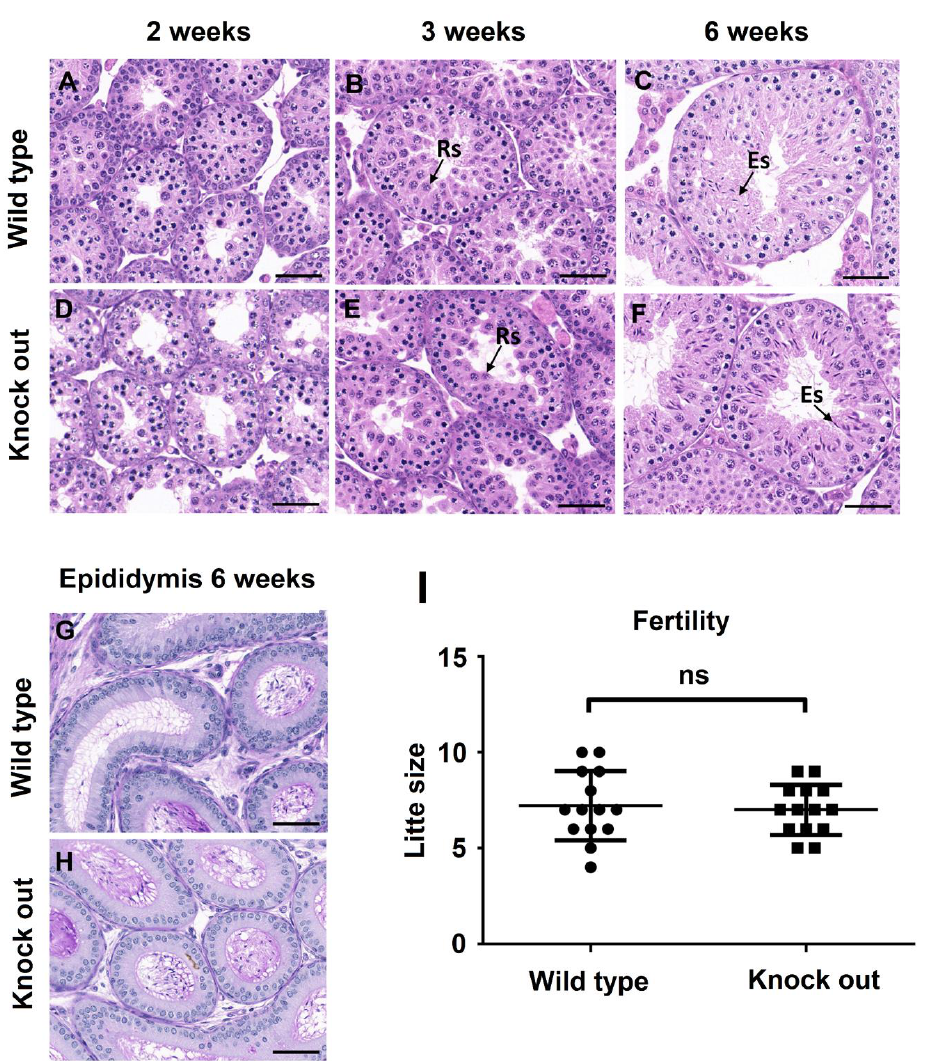
Figure 3. ASB17 − / − mice show normal spermatogenesis. ( A – F ) Histology of testes isolated from ASB17 +/+ and ASB17 − / − mice at the ages of 2, 3, and 6 weeks were revealed by hematoxylin and eosin (H&E). Arrows point to round spermatids (Rs) and elongated spermatids (Es). Bar = 50 μm. ( G , H ) Representative lumen of epididymis sections from wild-type ( G ) and ASB17 − / − ( H ) mice stained with periodic acid – Schiff (PAS). Bar = 50 μm. ( I ) Fertility evaluation of the wild-type and ASB17 − / − males, with bars indicating SEM.